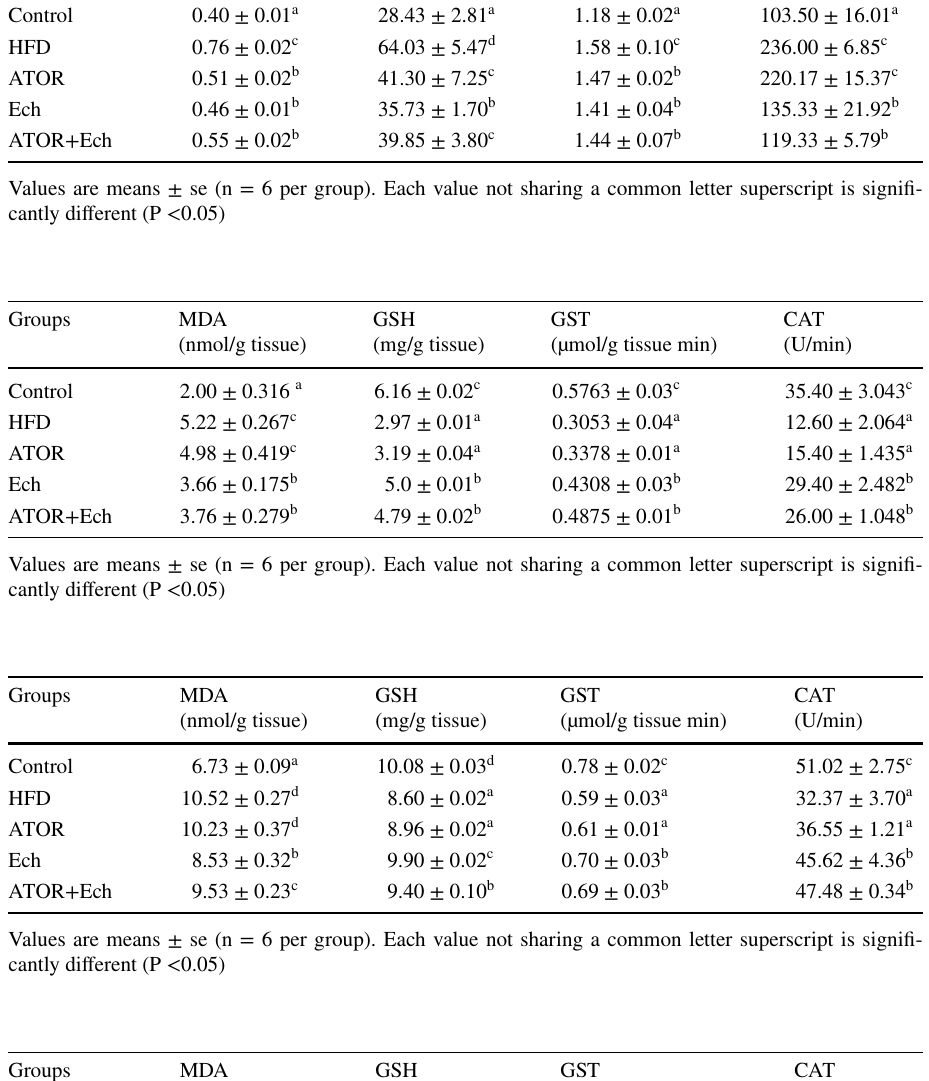
Table 3 Effect of Ech and ATOR on kidney and muscle biomarkers in hyperlipidemic rats